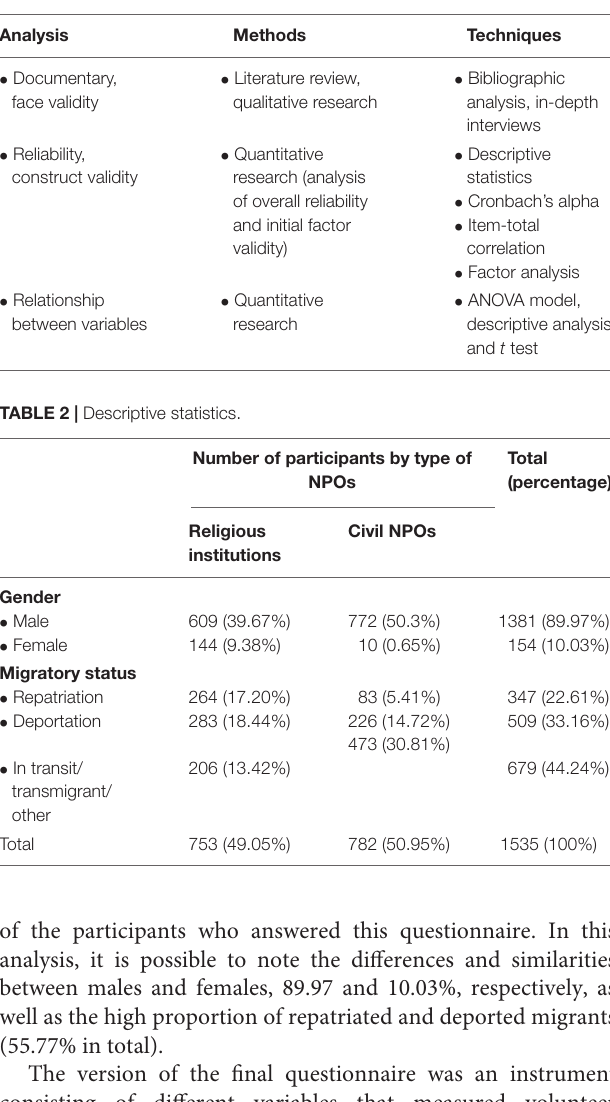
TABLE 1 | Methodology of this research.